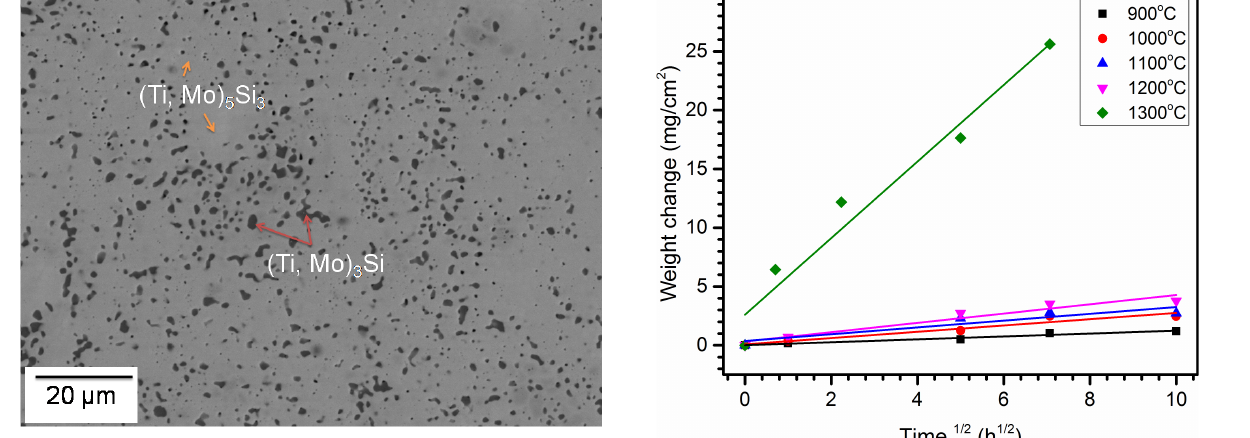
haviour of Mo-40Ti-30Si in static